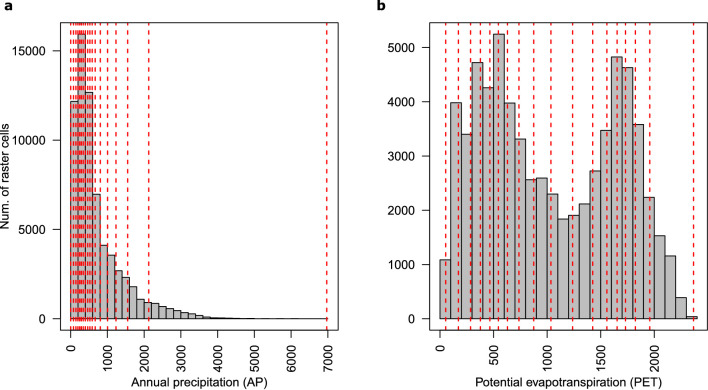
Distribution of (a) annual precipitation and (b) potential evapotranspiration values.Seventeen divisions of each climatic variable are presented with red dotted lines.